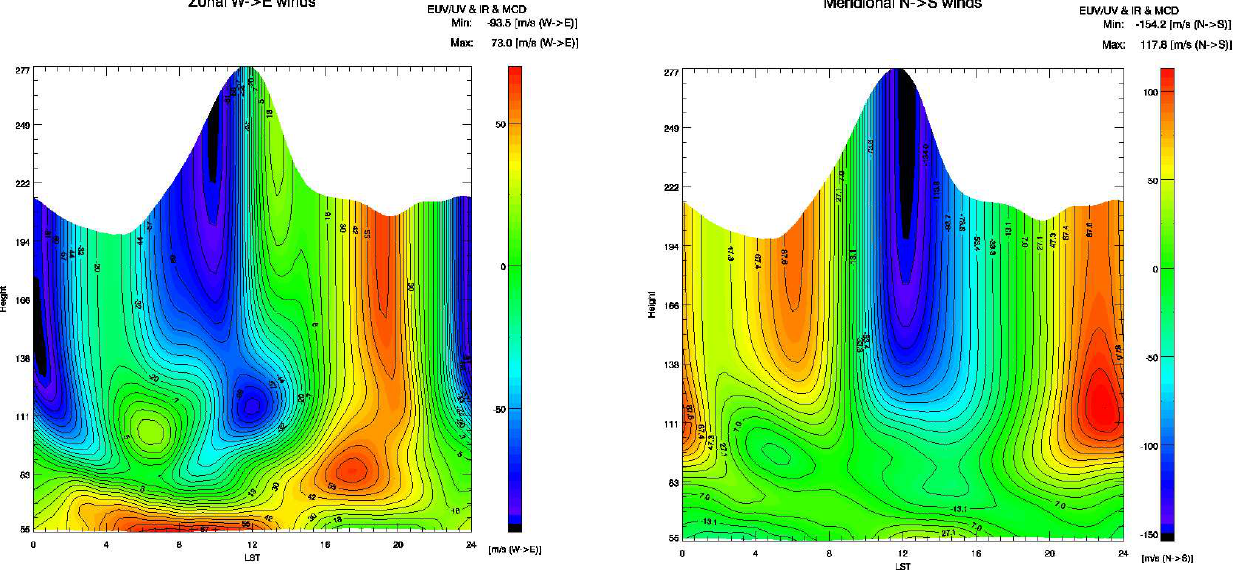
Fig. 14. The meridional wind velocity, local solar time (LST) vs height, from MarTIM+MCD, for solar minimum and L s =0 (cid:14) at +45 (cid:14) latitude